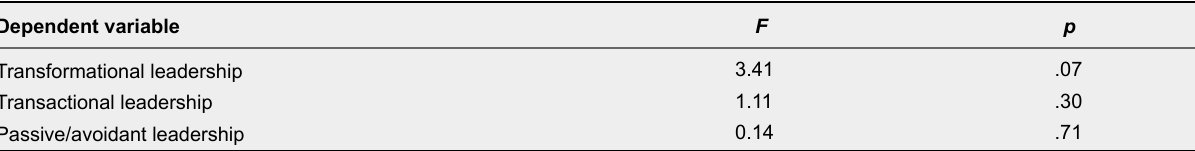
Levene’s Test Statistics for the Three MLQ Leadership Style Frequency Scores Dependent